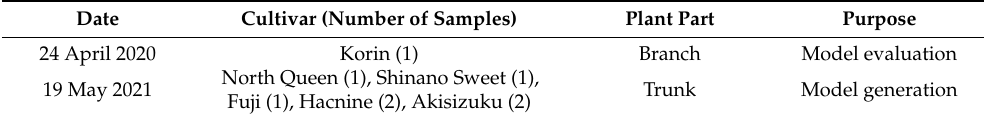
Figure 1. ( a ) Hyperspectral imaging of the infected branch; photos taken before ( b ) and after partially peeling off the bark ( c ). A browning lesion was found at the base of twigs after the peeling. A diagnostic model of AVC was generated based on the hyperspectral measurements of the trunks from seven apple trees sampled on 19 May 2021. The accuracy of the diagnostic model was evaluated using a hyperspectral measurement of a branch from an apple tree sampled on 24 April 2020 (Table 1). In addition, the model was assessed by using k-fold cross-validation (CV) with five cultivars (k = 5); the seven trunks were grouped into the five cultivars because one of the trunks had only a very small amount of healthy area. In the 5-fold CV, the accuracy was evaluated for each cultivar using the model generated from the other four cultivars. Table 1. List of apple trees used in this